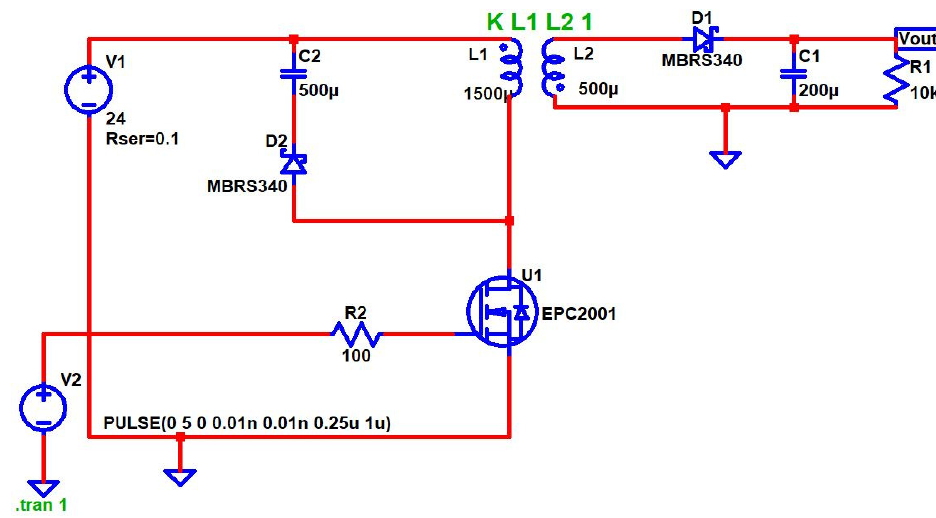
Figure 7. DC-to-DC flyback converter circuit response with a resistive load.